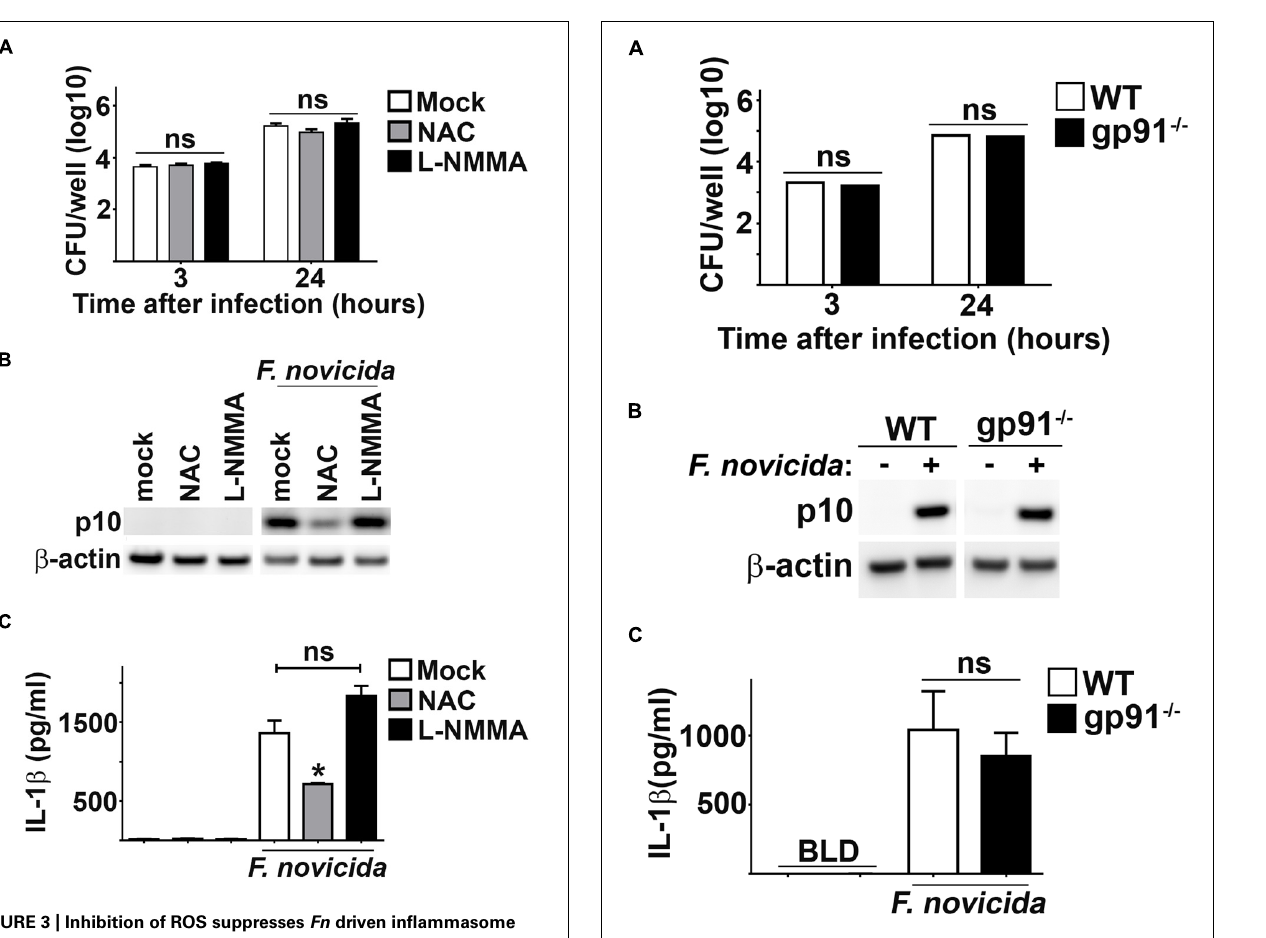
FIGURE 4 | NADPH oxidase does not contribute to Fn mediated activation of the inflammasome. BMM from wild type (WT) or gp91/nos2 − / − (gp91 − / − ) mice were infected with Fn MOI 250. (A) Intracellular bacteria were enumerated at the indicated times after infection. (B) Western blots of cell lysates were probed for caspase-1 p10 and actin. (C) Culture supernatants were assessed for IL-1 β by ELISA. Error bars depict SD. ns, not significant. Data are representative of three experiments of similar